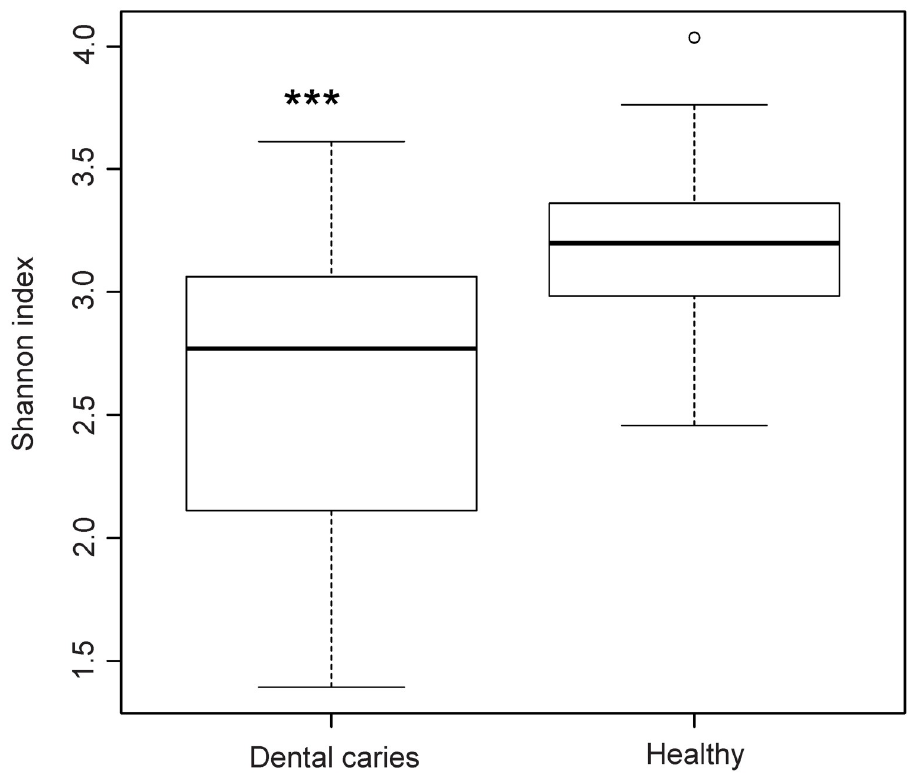
Fig 5. Microbial diversity. Boxplot of the non-parametric Shannon index evaluating the effect of group assignment on microbial diversity.